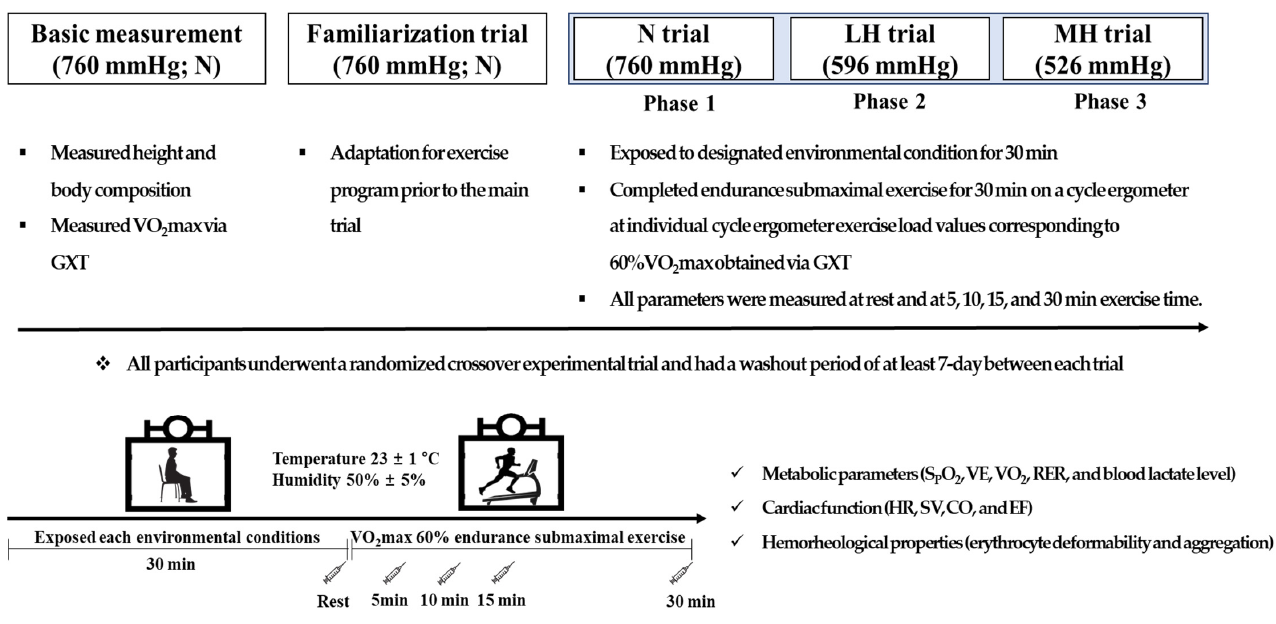
Figure 2. Study design. N: endurance submaximal exercise under normoxia; LH: endurance sub- maximal exercise under light hypoxia (596 mmHg, simulated 2000 m); MH: endurance